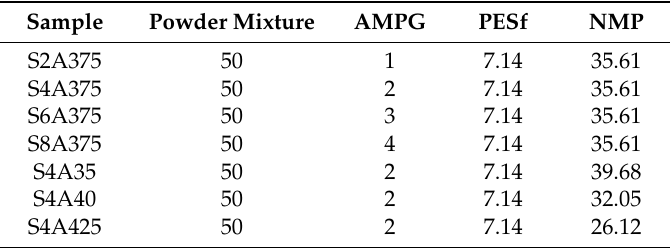
Table 1. Composition of the ceramic slurries (in